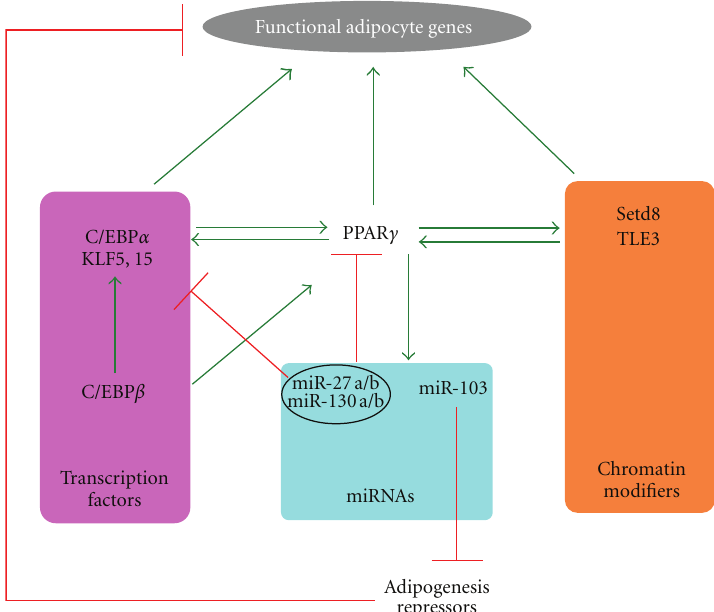
Figure 2: Integrated regulation of PPAR γ expression and activity in adipocytes. Schematic showing transcriptional regulators involved in control of PPAR γ expression and activity in adipocytes. Green arrows, positive regulation; red bars, negative regulation. See text for further